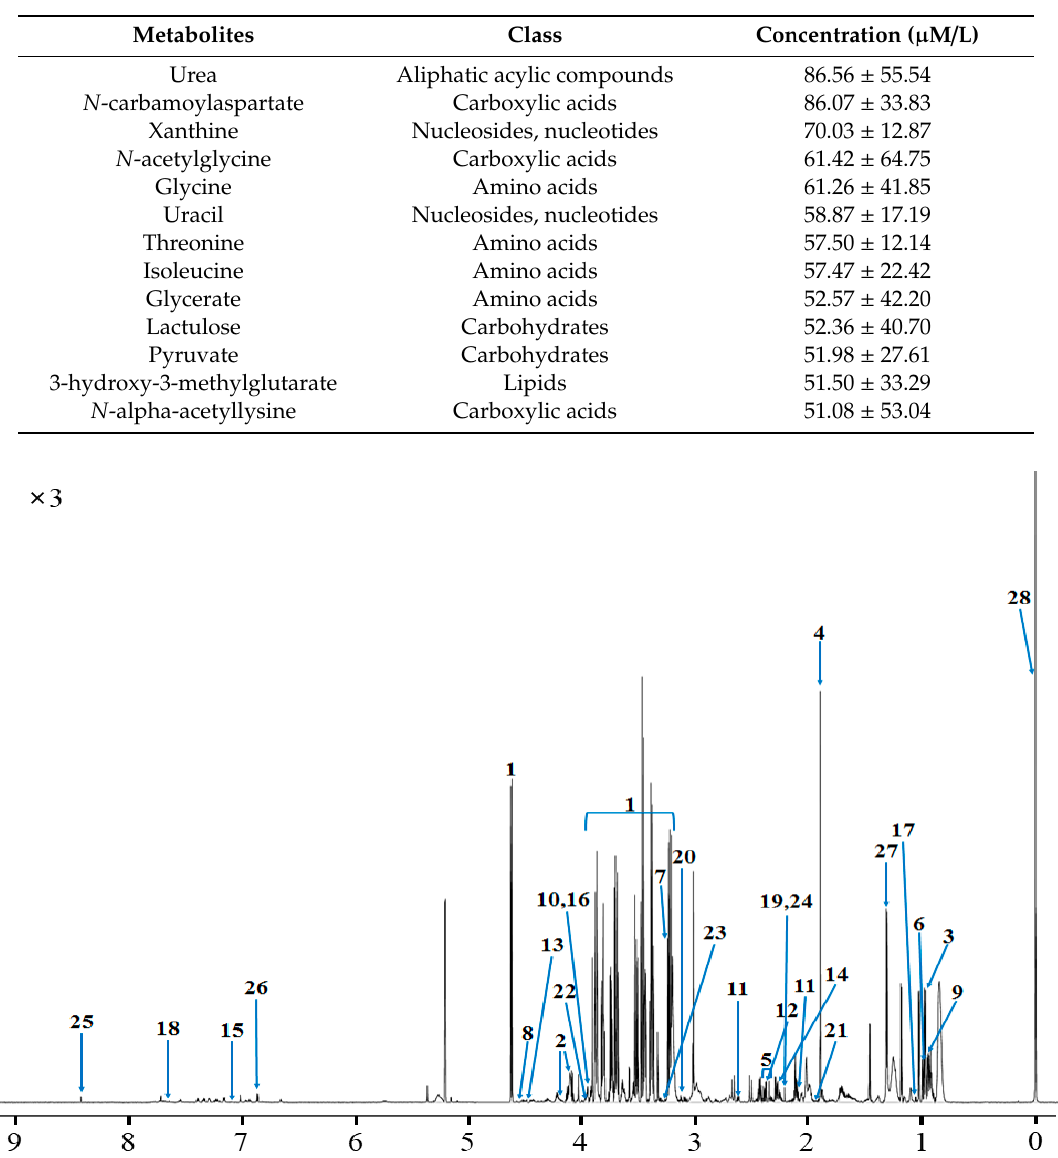
Figure 2. The representative spectrum 1 H-NMR spectroscopy obtained from Hanwoo steers